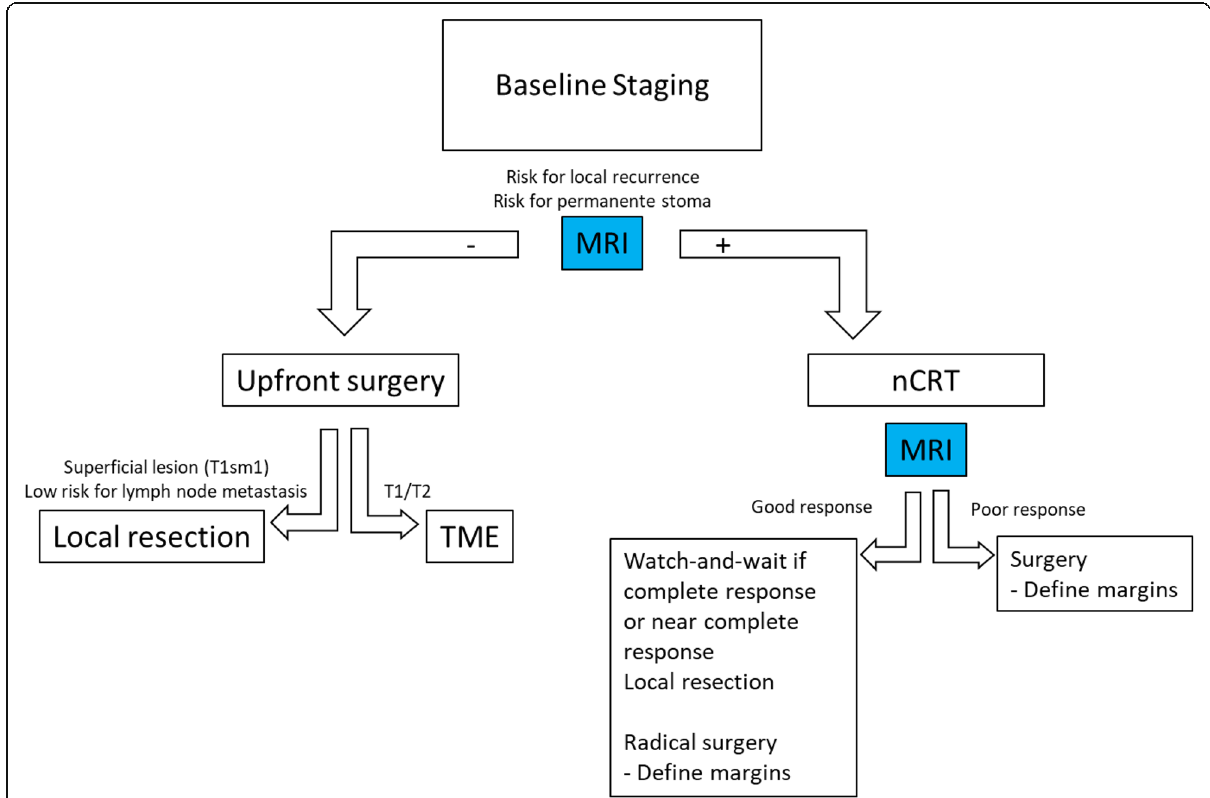
Fig. 1 Roles of MRI in staging patients with rectal cancer